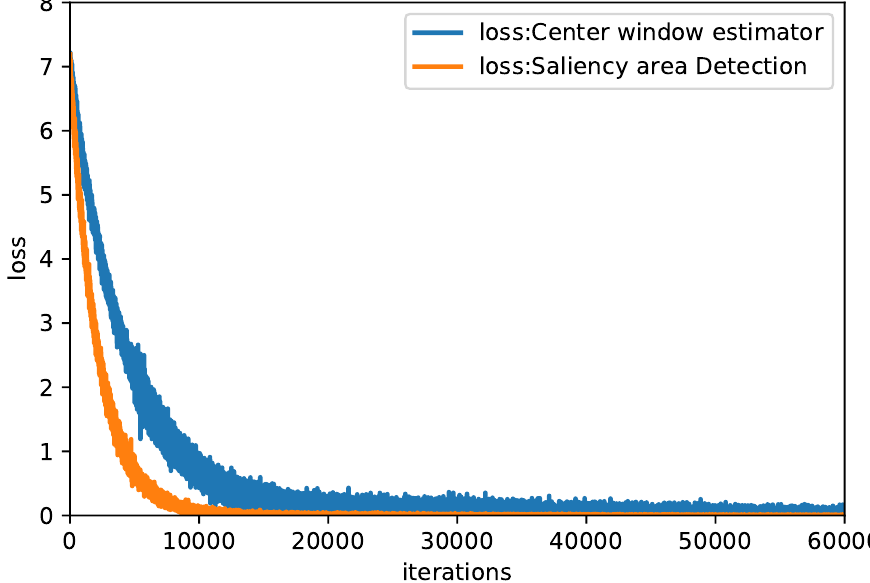
Figure 8. Training loss of SR-Net. The loss of saliency region detection has converged at 10,000 iterations. The loss of the center window estimator requires 60,000 iterations to fully converge.